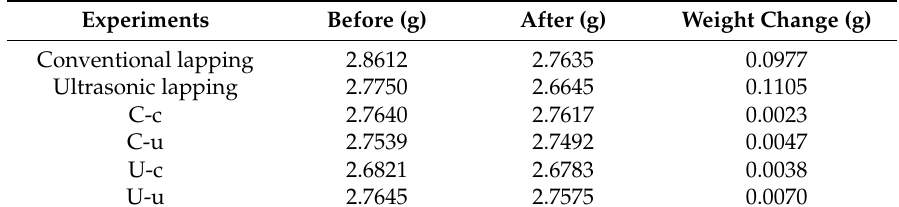
Table 4. Weight loss before and after processing.